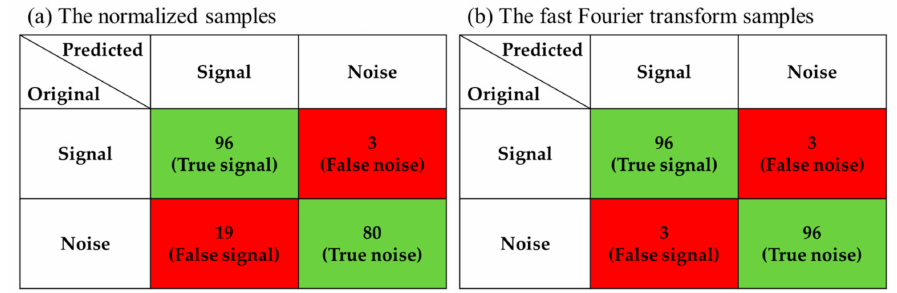
Figure 15. The clustering results of ( a ) the normalized and ( b ) the FFT data by